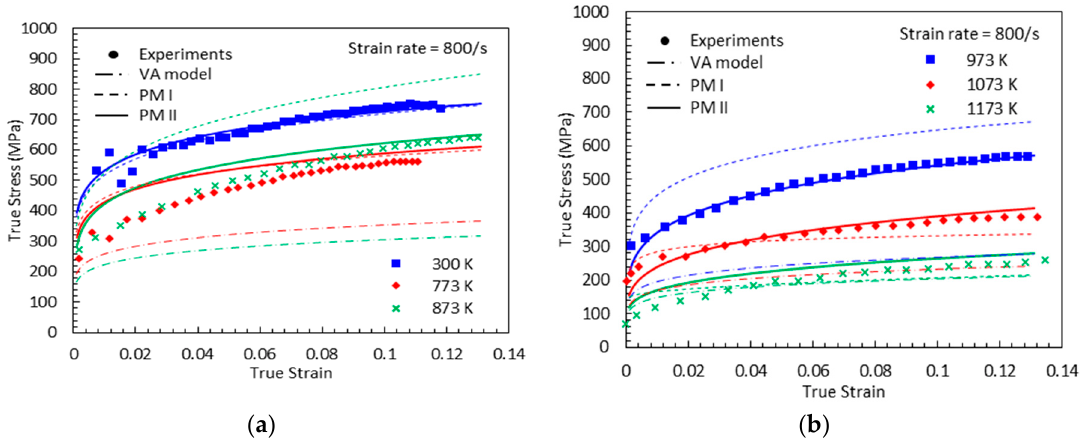
Figure 21. True stress-true strain curves from experimental measurement [1] , predictions by the VA model, PM I, and PM II with (cid:2013)(cid:4662) = 800 (cid:1871) (cid:2879)(cid:2869) : ( a ) (cid:1846) = 300,773 and 873 (cid:1837) ( b ) (cid:1846) = 973, 1073 and 1173 (cid:1837) .